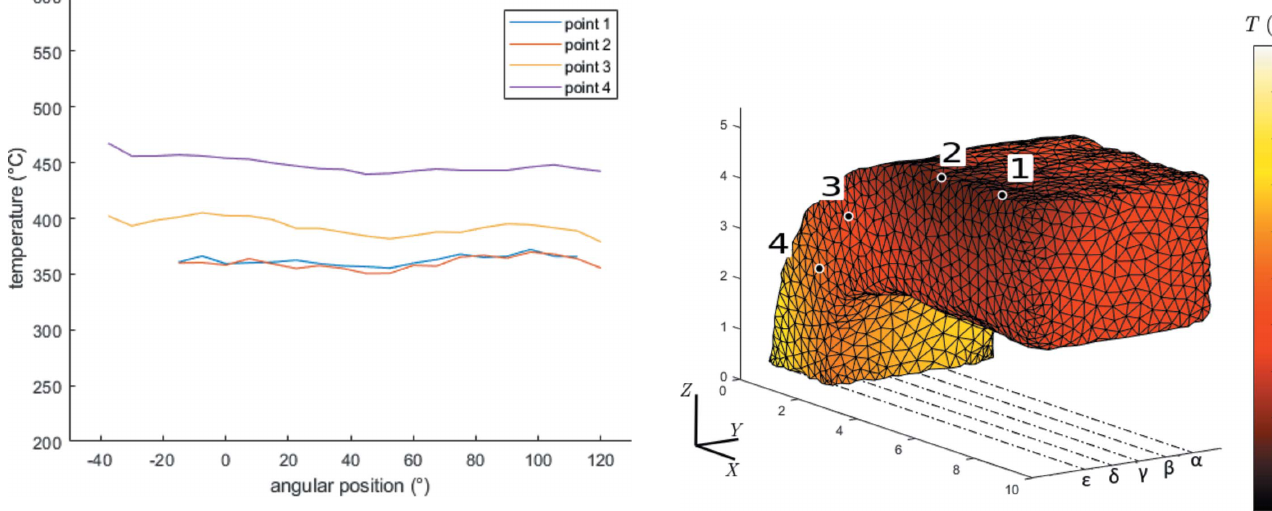
Figure 5 Reprojection of the thermal field measured at the initial step. The thermal gradient along the X direction is representative of operating conditions. The points in black surrounded by white correspond to the points of Fig. 4, and the Greek letters correspond to the slices shown in Fig.